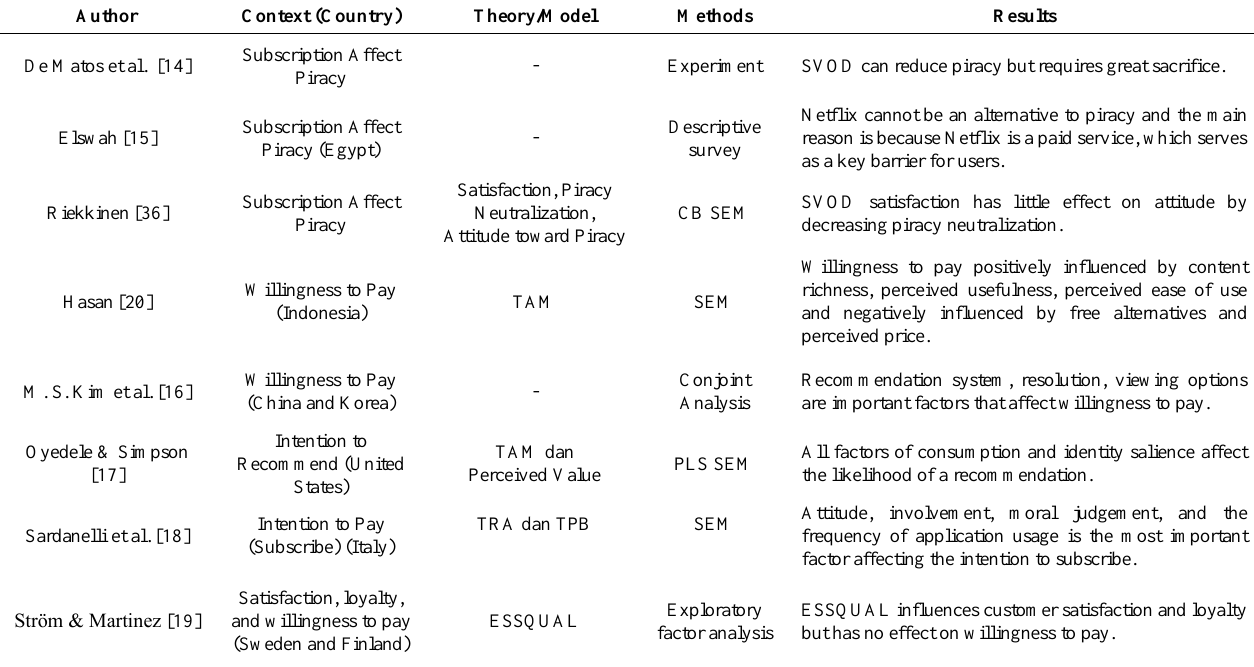
Table 1. Summary of Past Research Related to Movie Streaming